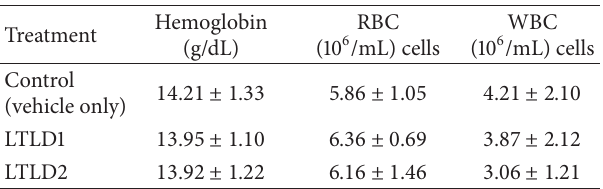
Table 2: Effect of LTL treatment on haematological parameter in mice.